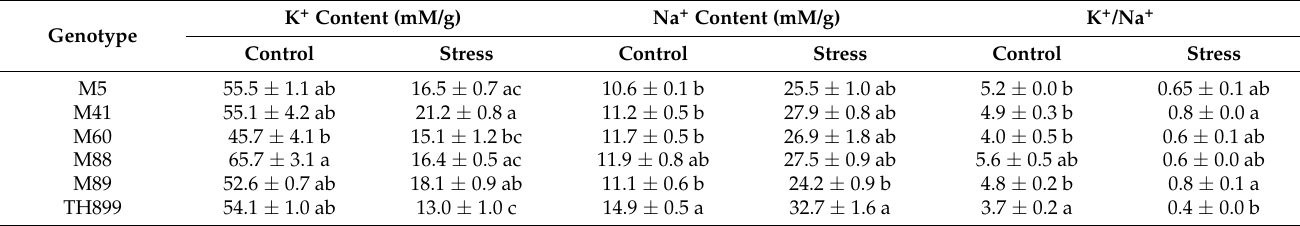
ratio ranged from 0.58 to 0.76, which was higher than that of TH899 (0.40). Table 3. K + and Na + content and K + /Na + ratio of mutant lines and TH899 under control and saline–alkaline stress conditions.